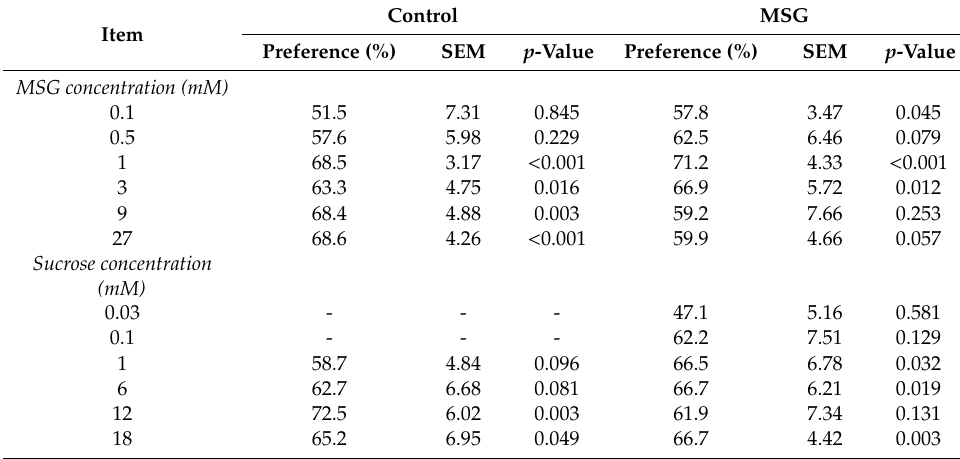
Table 3. Preference values for di ff erent concentrations of MSG and sucrose solutions in post-weaning pigs born from control and MSG-fed sows 1 .